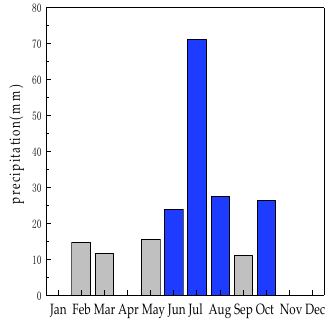
Figure 15. Urad front banner monthly precipitation in 2017.